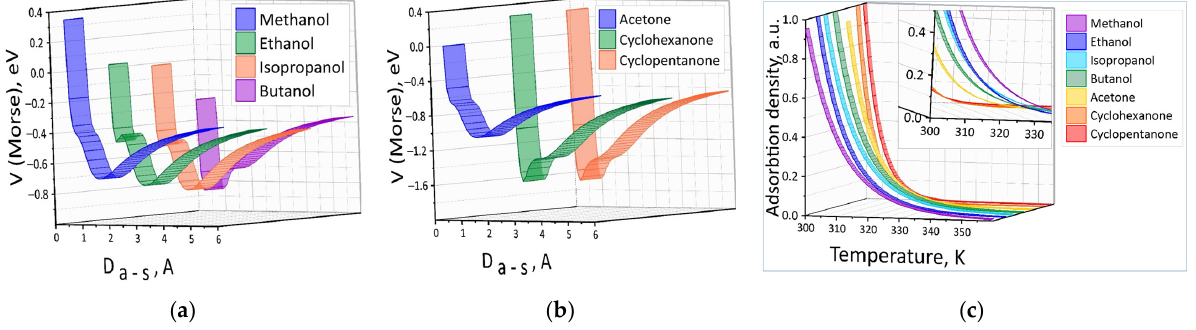
Figure 5. Energy profiles of physical adsorption of the ketone ( a ) and alcohol ( b ) molecules on the surface of the SnO 2 film and the density of adsorbed analytes per unit area ( c ). Table 1. Electrophysical quantities of the analyte molecules on the surface of the SnO 2